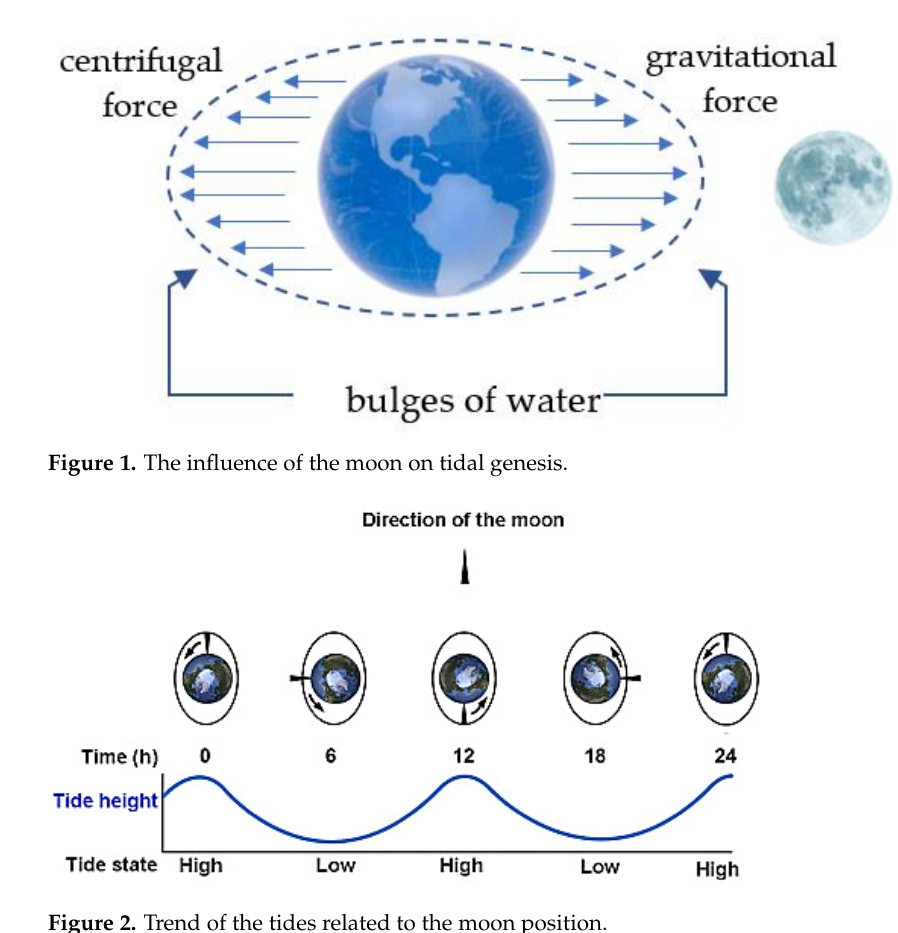
Figure 2. Trend of the tides related to the moon position.